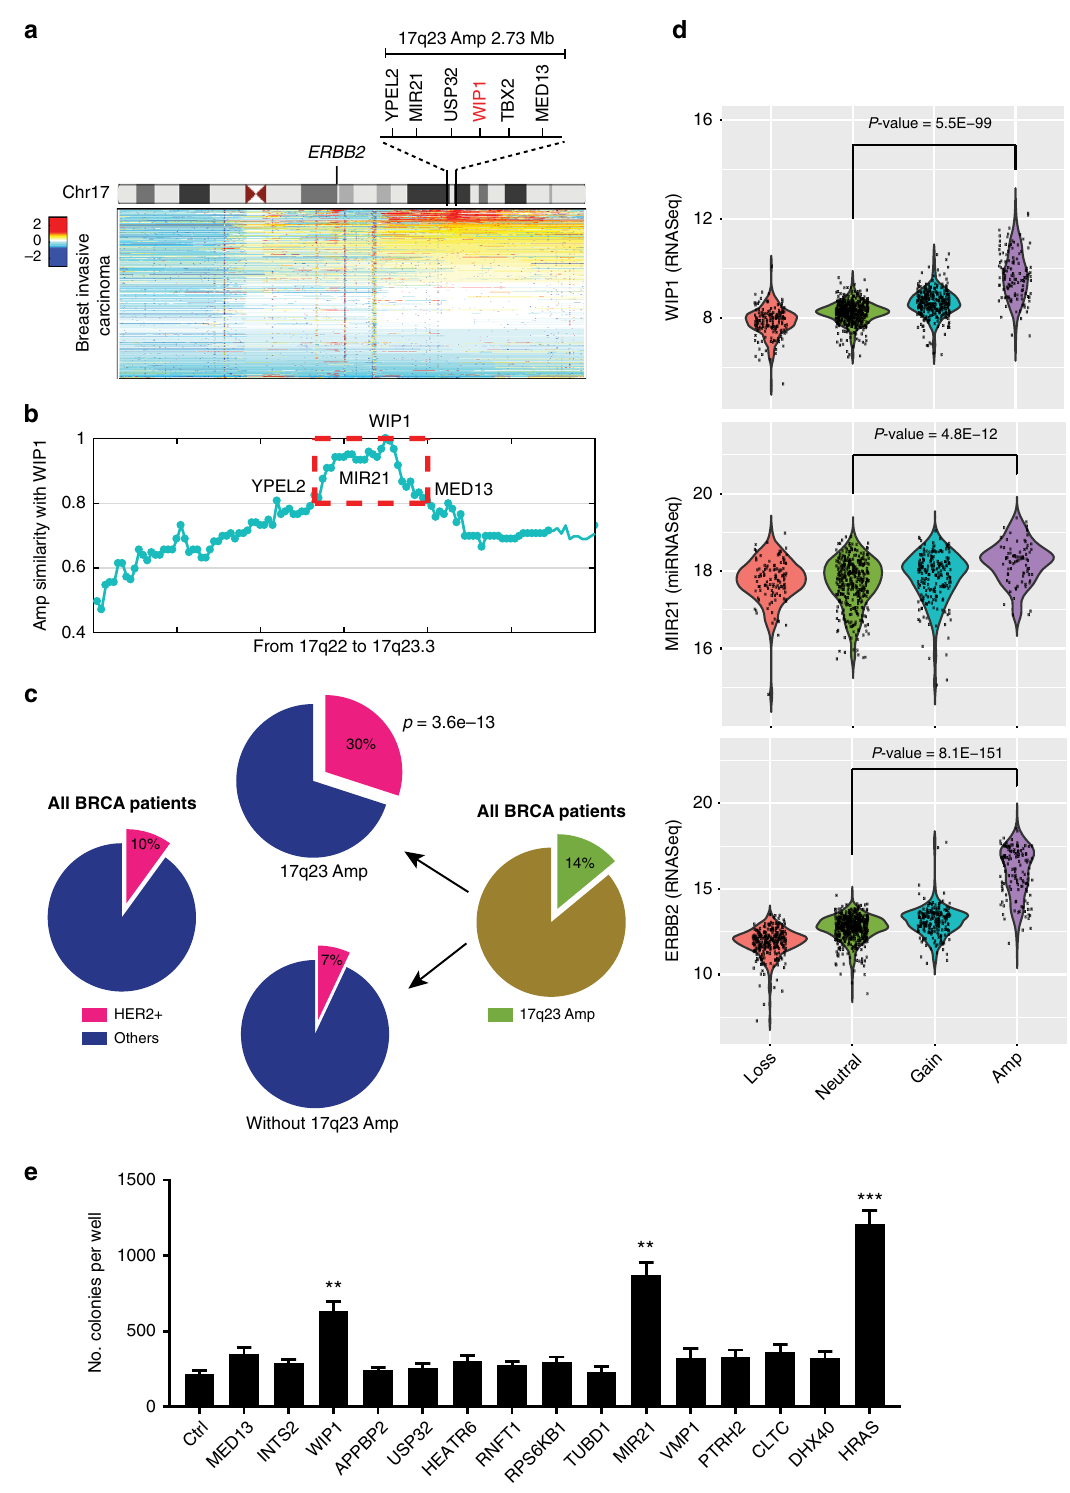
Fig. 1 Association between gene ampli fi cation, gene expression and HER2 + breast cancer on chromosome 17. a Heatmap of genomic segment copy- number abnormalities (log-ratio measurements) of human chromosome 17 in 1,080 breast invasive carcinomas. Positive log-ratios indicate degree of copy number gain (red) whereas negative values mark the loss (blue). b Co-ampli fi cation of WIP1 and genes from 17q22 to 17q23. c HER2 + subtype signi fi cantly enriched in breast cancers harboring WIP1 -contating 17q23 amplicon. The TCGA dataset was downloaded from Xena Public Data Hubs (see Methods for details). d Correlation between gene expression aberration and copy number variation for genes, WIP1 , MIR21 , and HER2 ( ERBB2 ) in breast tumors. e Soft agar colony formation assays with MMTV-ErbB2 mouse mammary epithelial cells transduced with control vector (Ctrl) or lentiviral vector expressing the indicated genes. ** p < 0.01; *** p < 0.001; unpaired 2-tailed t -test was used ( d , e ). Data are presented as mean ± SD and are representative of 3 independent